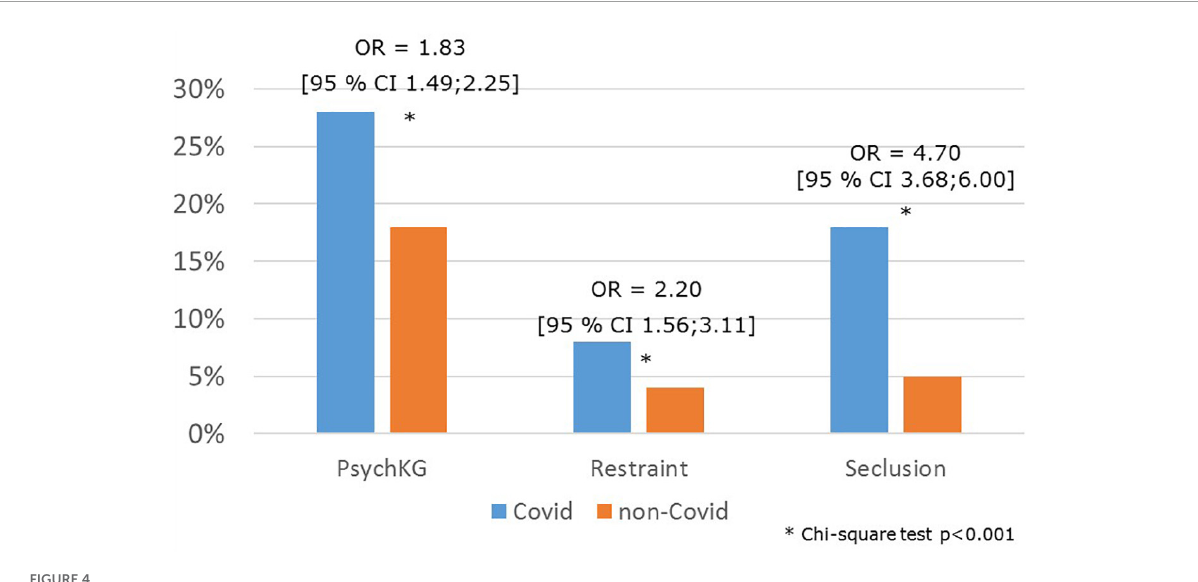
FIGURE4 Rates of coercion among psychiatric inpatients with COVID-19. Given are the rates of cases of involuntary hospitalization [Psych KG, indicating the North-Rhine Westphalia Mental Health Act (Psychisch Kranke Gesetz NRW)], and rates of cases with seclusion and restraint in psychiatric inpatients with COVID-19 infections compared to patients without COVID-19 infection. Observation period: 1 January 2020 until 30 June